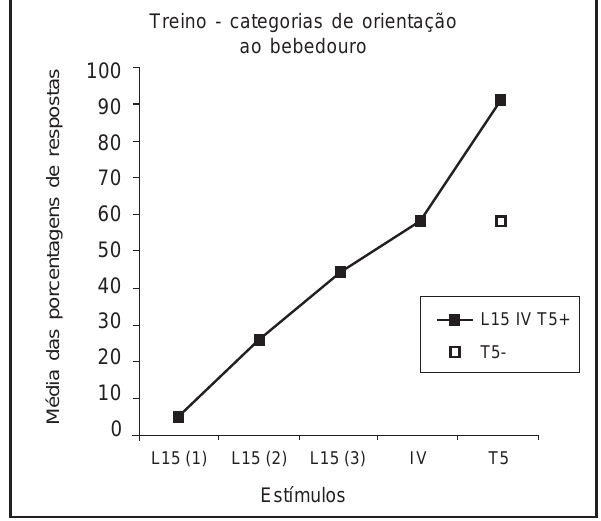
Figura 1. Médias das porcentagens de resposta das categorias de orientação ao bebedouro agrupadas (head-jerk+lamber e\ou farejar o bebedouro) nas práticas L15 IV T5+ e T5-, durante as cinco últimas sessões da fase de aquisição. L= luz; T=Tom; IV= intervalo vazio; L15(1), L15(2) e L15(3) correspondem a blocos de 5 segundos de